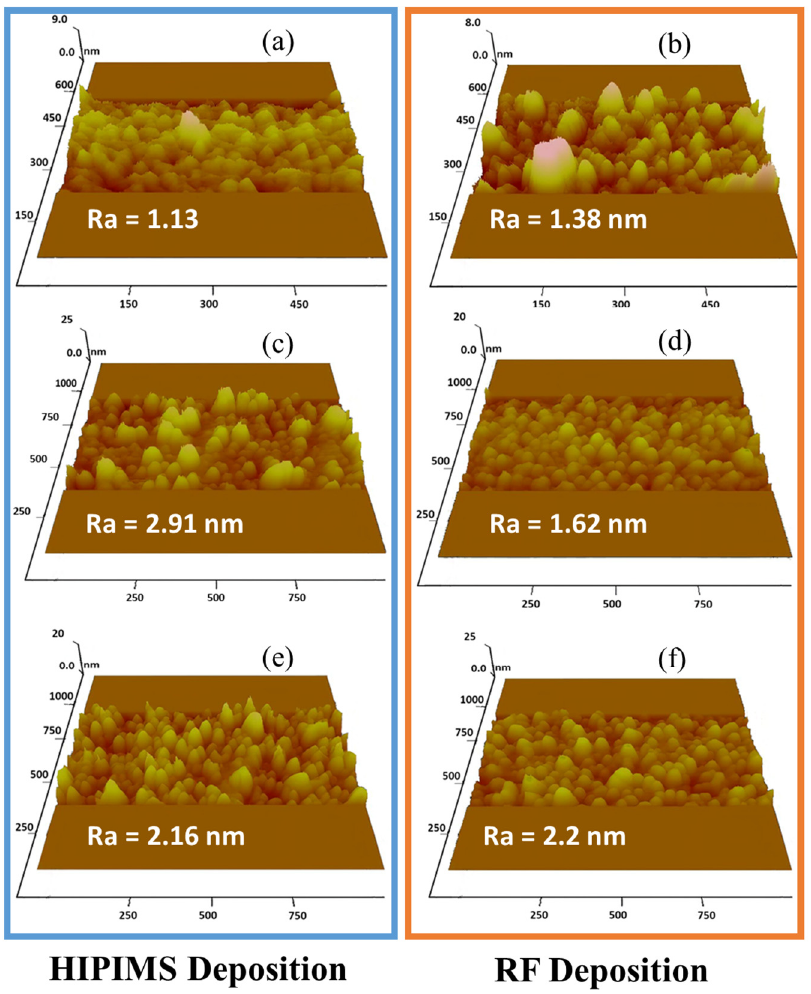
Figure 4. AFM-generated surface morphology plots, including the average roughness value of each deposition. ( a ): 50 W HiPIMS, ( b ) 50 W RF, ( c ) 100 W HiPIMS, ( d ) 100 W RF, ( e ) 150 W HiPIMS, ( f ) 150 W RF.